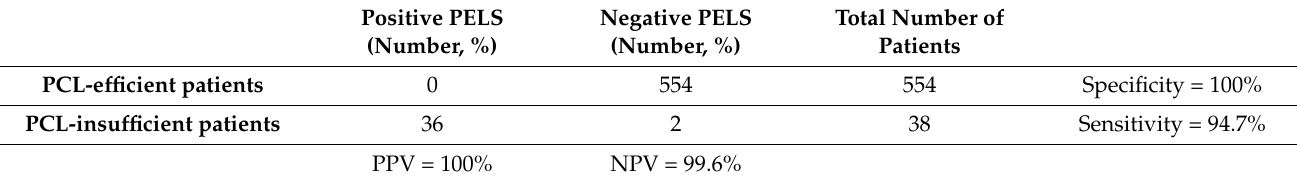
Table 2. Presence of the PCL envelope lack sign (PELS) in the study and control groups and its diagnostic characteristics. Positive PELS Negative PELS Total Number of (Number, %) (Number, %) Patients PCL-efficient patients 0 554 554 Specificity = 100% PCL-insufficient patients 36 2 38 Sensitivity = 94.7% PPV = 100% NPV =